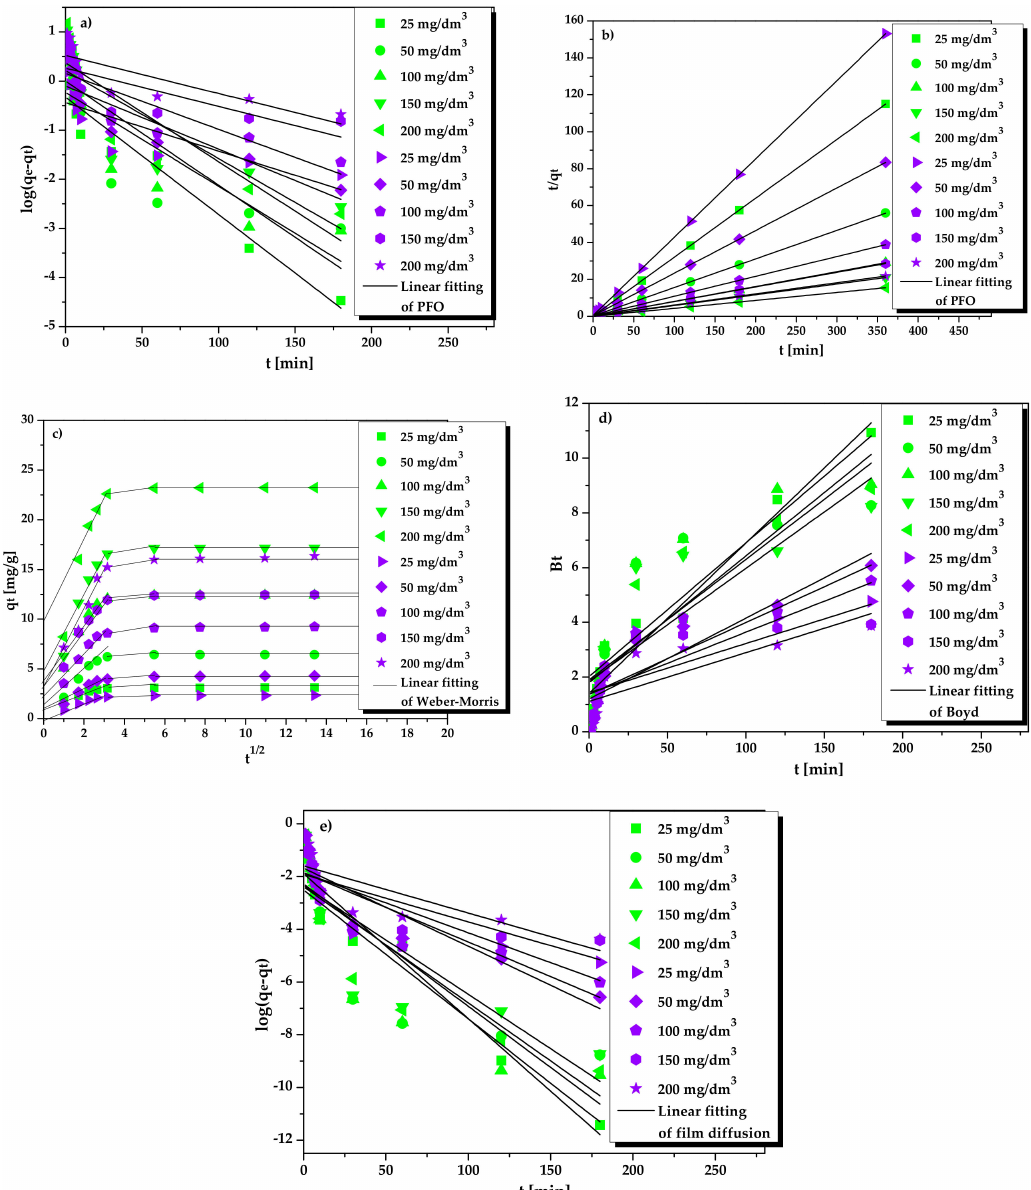
Figure 8. Experimental data fitting for La(III) (green symbols) and Ni(II) (violet symbols) ions sorption on Lewatit Monoplus SP112 for the ( a ) pseudo-first order, ( b ) pseudo-second order, ( c ) Weber-Morris intraparticle di ff usion, ( d ) Boyd, and ( e ) film di ff usion kinetic